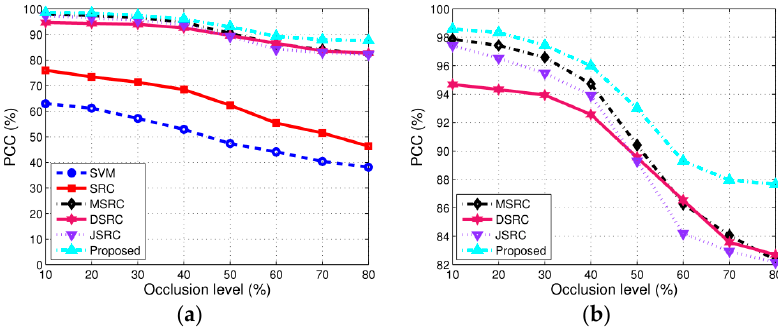
Figure 12. Performance under partial occlusion from direction 3. ( a ) Single view methods; ( b ) Multi-view methods.